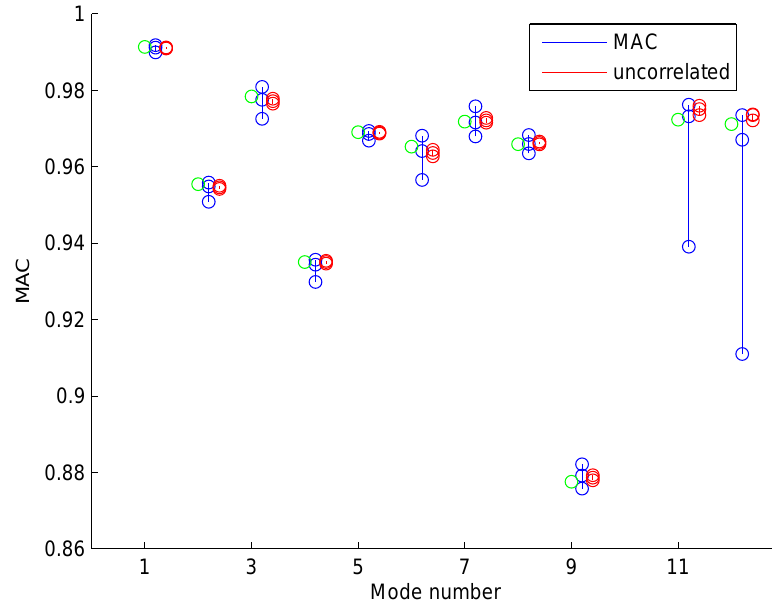
Figure 10. Posterior robust predictions for the mode shapes compared with the experimental mode shapes using the MAC value, under the vector-based (uncorrelated) and MAC-based formulations for the likelihood. Vertical lines (with three circles) for each mode number show the 5%, 50% and 95% quantiles. The isolated green circles show predictions from the nominal FE